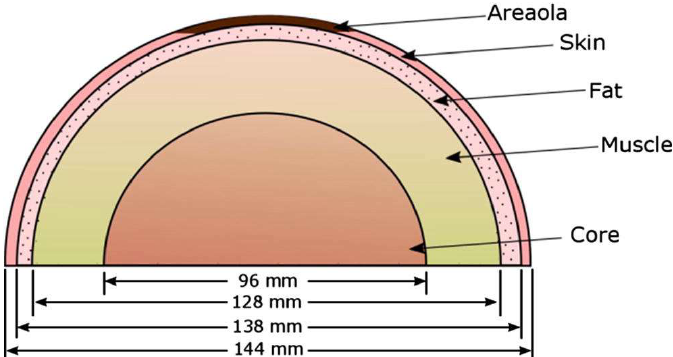
Figure 4. Hemispherical domain with non-concentric layers, which is a prevalent model because of its ability to reproduce the surface temperature [22,24].